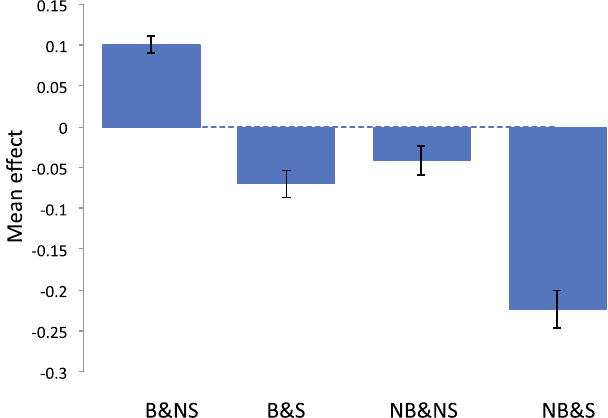
Figure 5. Mean trait value of educational attainment for each group classified by breastfeeding and maternal smoking status. Vertical bar is 95% confidence interval. The phenotypes of educational attainment were adjusted for birth year, age at recruitment, sex, assessment centre, genotype measurement batch and 15 principal components.